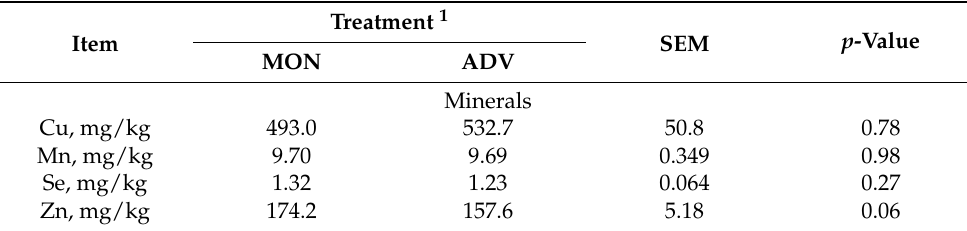
Table 6. Liver concentrations of Cu, Mn, Se and Zn in Nellore bulls finished on pasture with high concentrate supplementation, with monensin (MON) or a blend of live yeast and organic minerals (ADV).